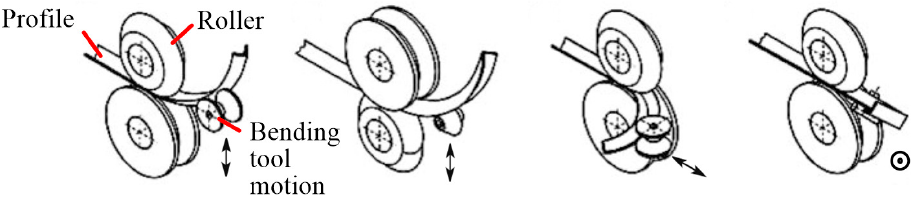
Figure 15. Schematic of the integrated rolling–bending process [38,62]. Reproduced with permission from ref. [38]. Copyright 2007 Springer-Verlag Berlin Heidelberg.